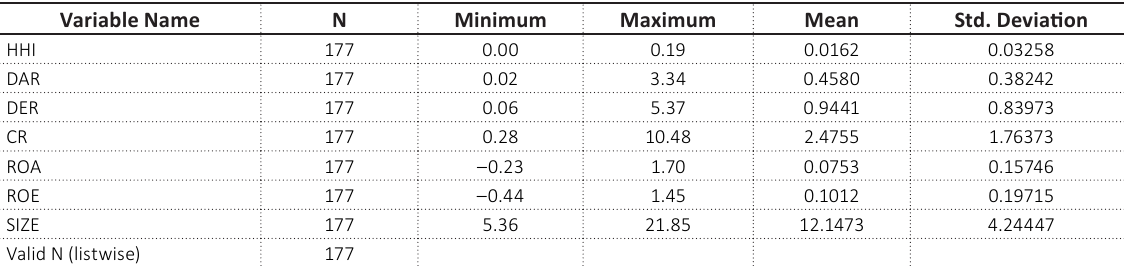
Table 2. Descriptive